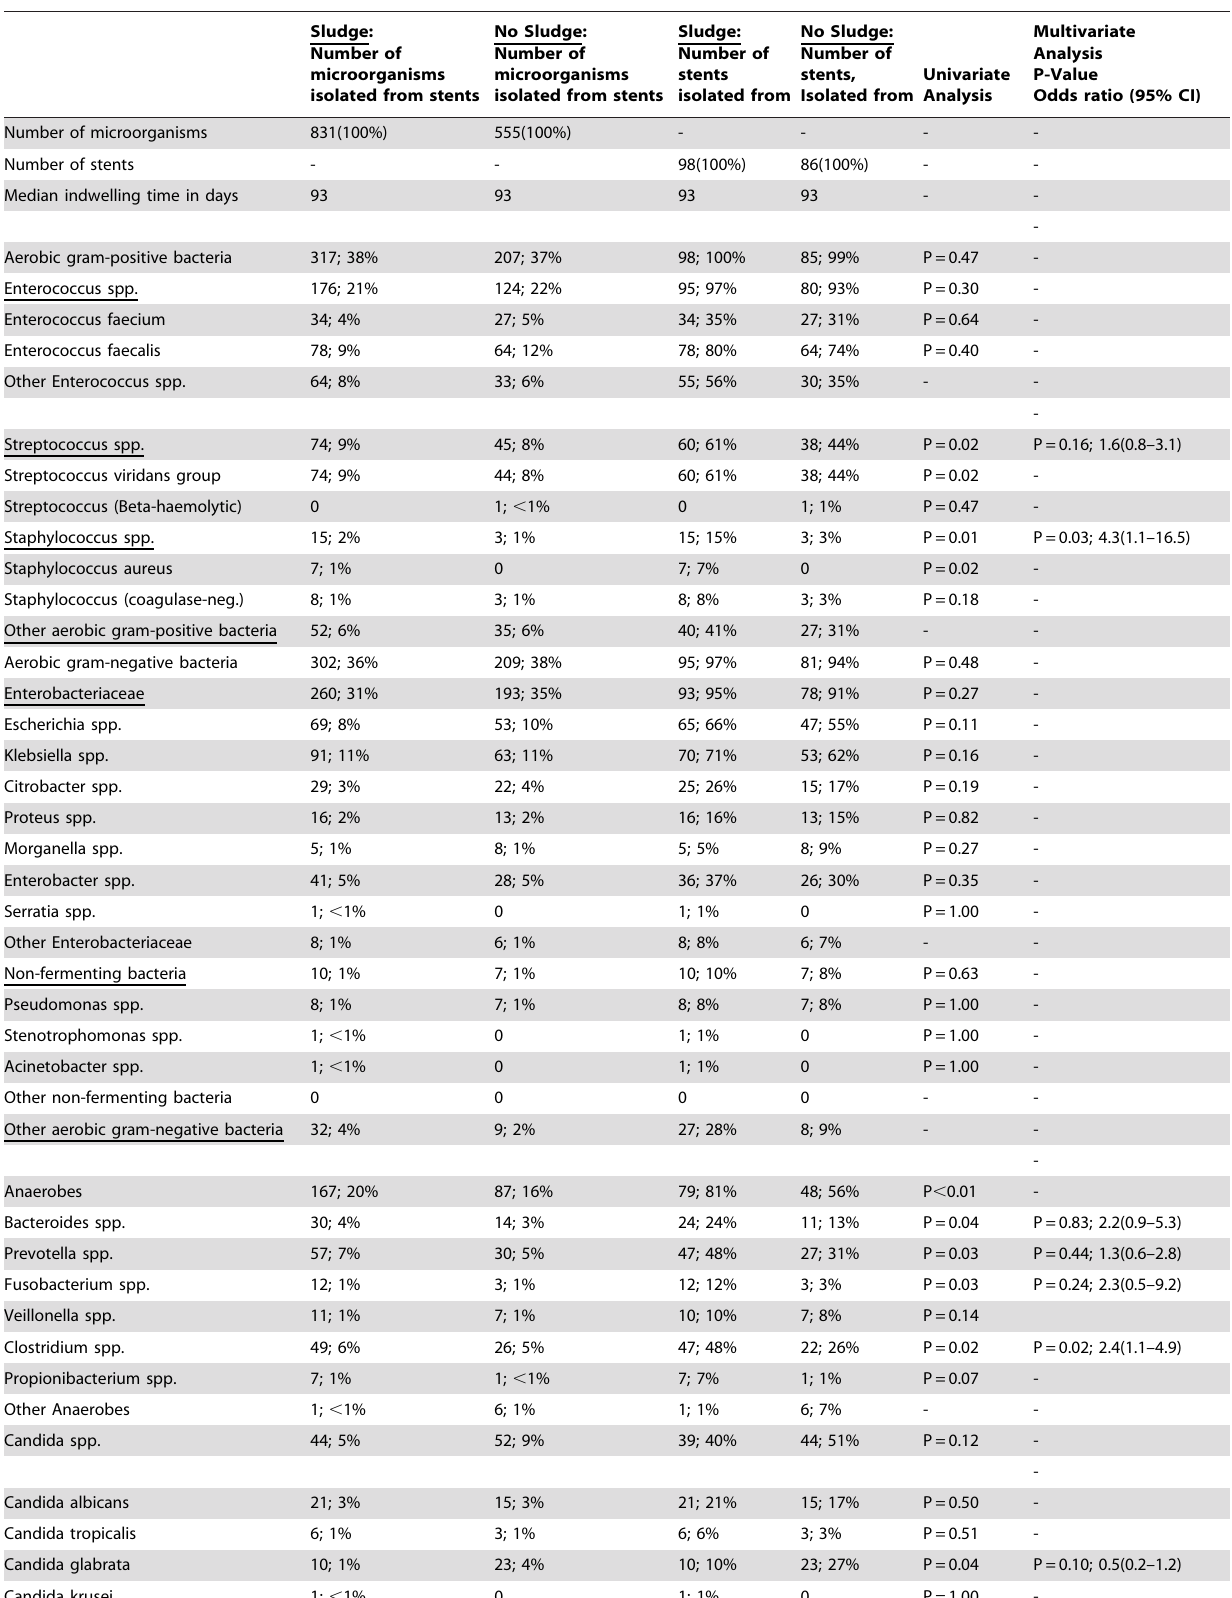
Table 4. Comparison of the spectrum of microorganisms between stents with and without sludge.